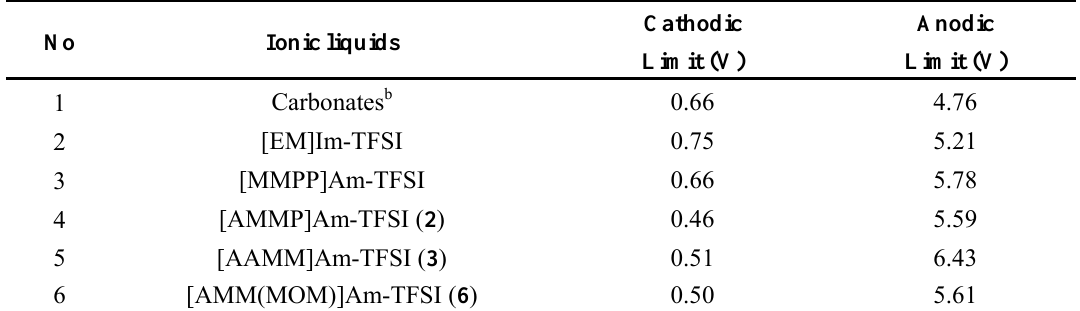
Table 3. Electrochemical stability windows of the ILs with 1.0 M LiTFSI a .